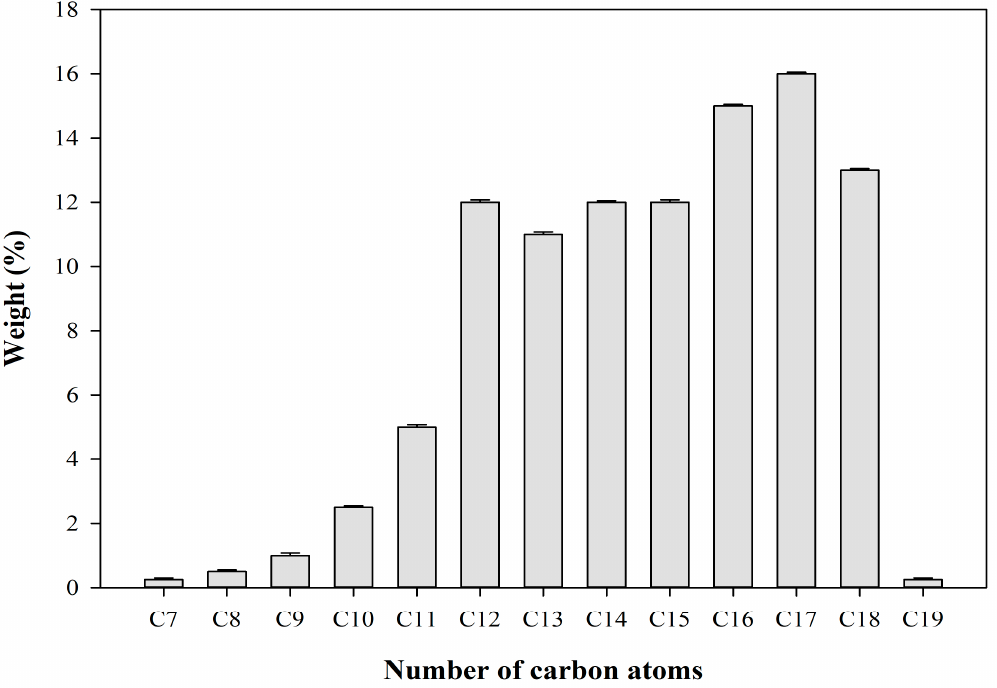
Figure 7. Number of carbon distribution of refined biofuel obtained from hydrocracking reaction (SD < 0.05).